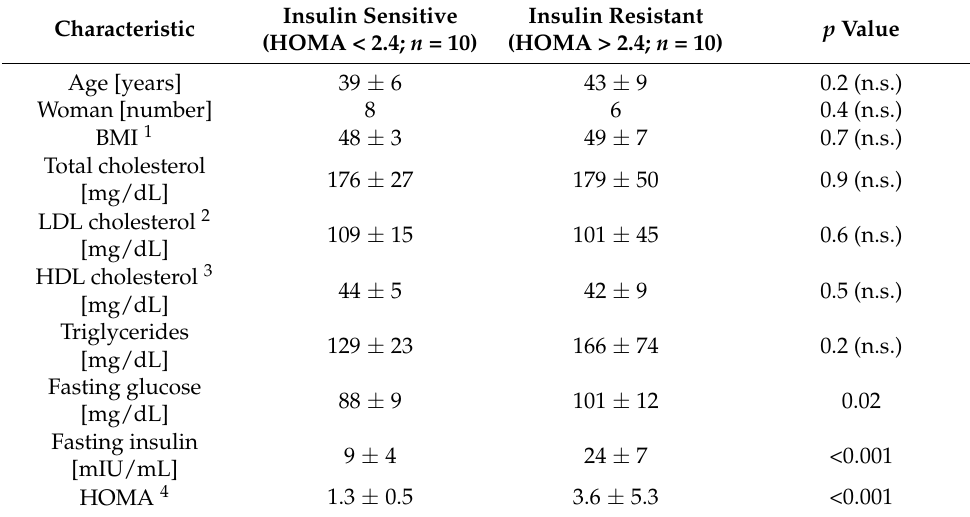
Table 2. Metabolic parameters of the GSE20950 cohort (modified [18]).